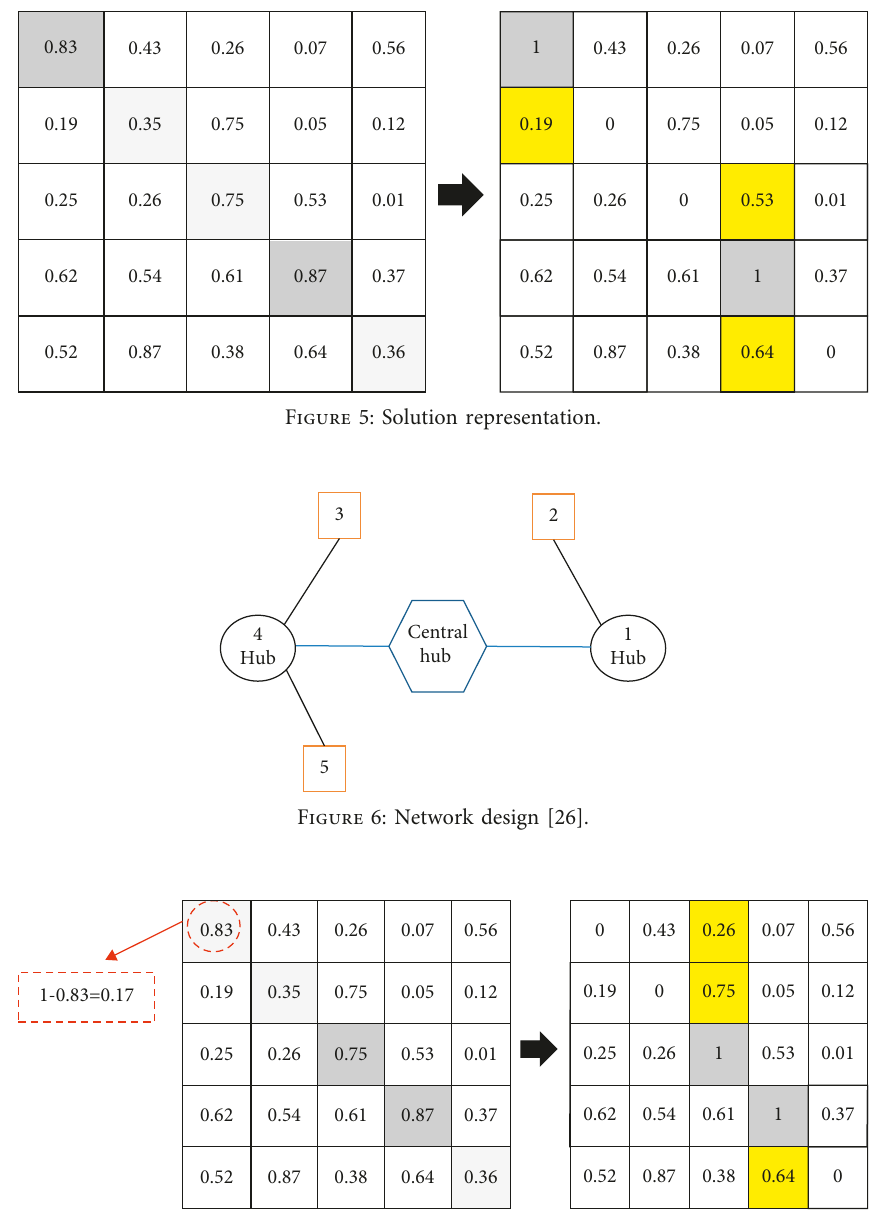
Figure 7: Mutation operator. Table 2: Sample problems parameters